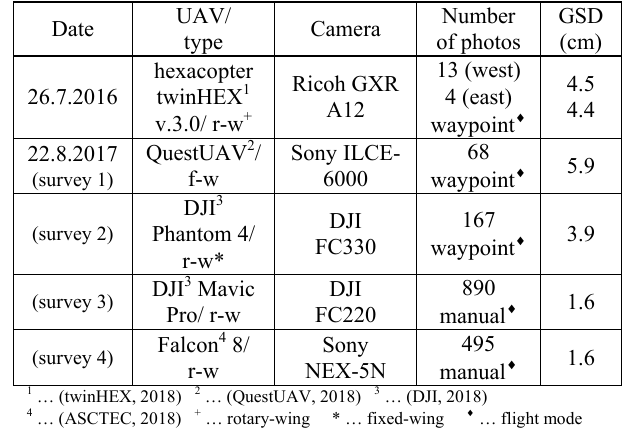
Table 2. UAV-based aerial surveys 2016-2017